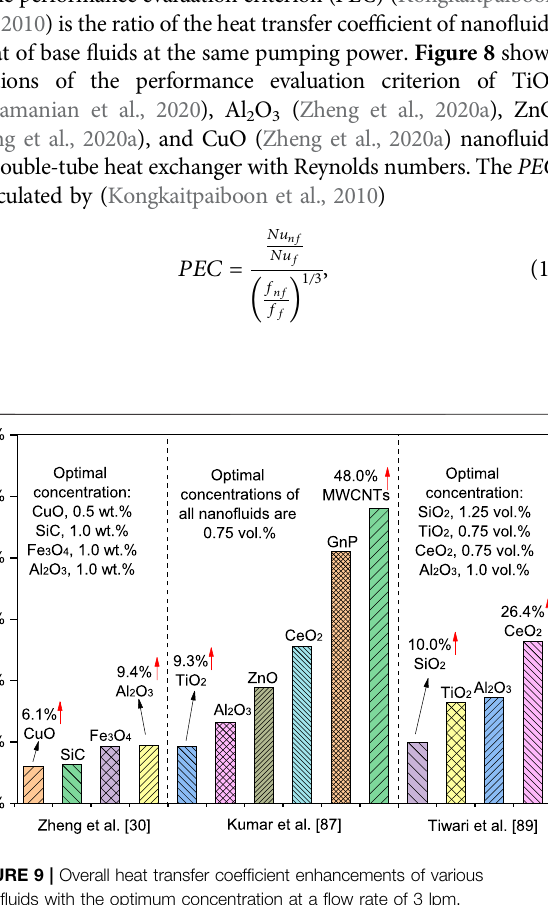
Frontiers in Energy Research |